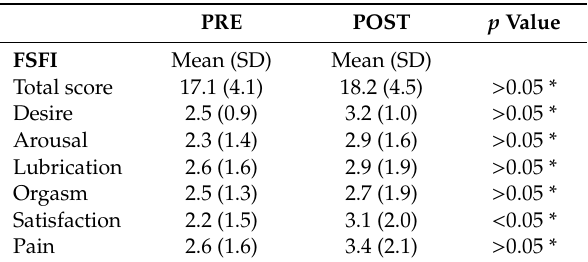
Table 4. Sexual function